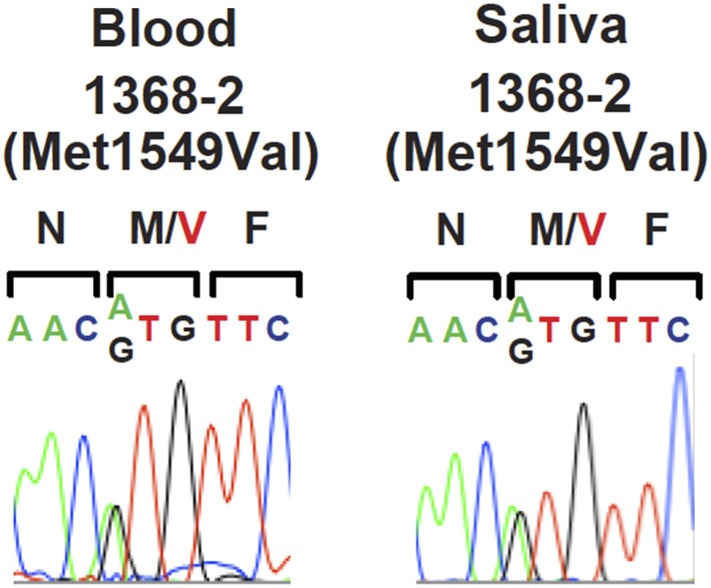
DOI:
http://dx.doi.org/10.7554/eLife.06315.020